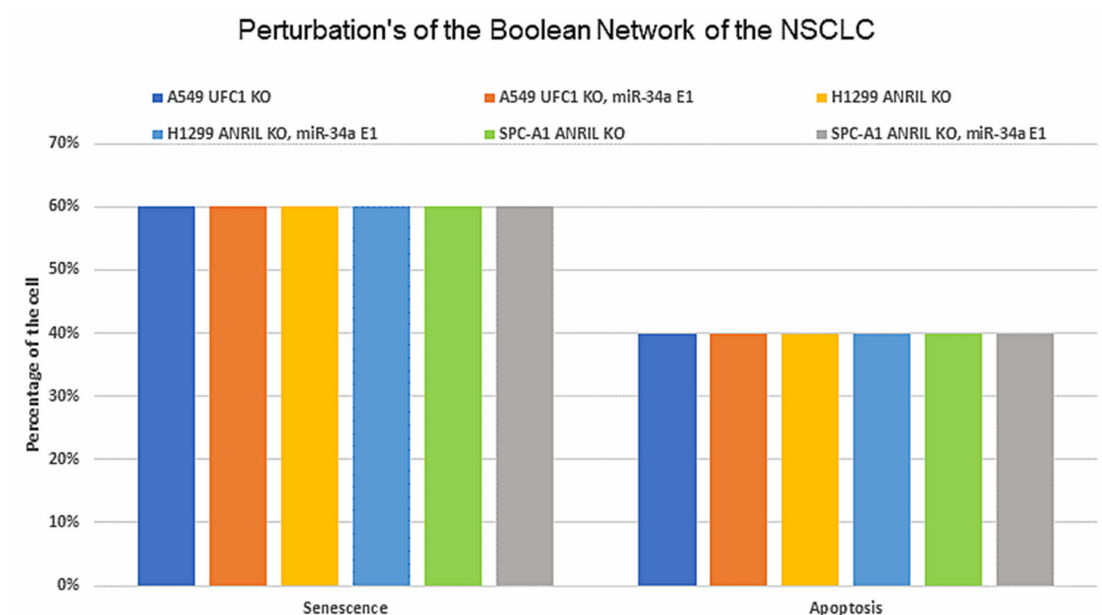
Figure 3. Probabilities of perturbed cases of Boolean networks using Monte Carlo simulations (100,000 runs) and comparison with experimental studies by Zang et al. [3] and Nie et al. [2]. Each bar represents a specific case of the perturbation. As such, the first case is UFC1 KO in A549 cells, the second case is UFC1 KO along with miR-34a E1 in A549 cells. The third case is ANRIL KO, while the fourth case is ANRIL KO together miR-34a E1 in H1299 cells. The fifth case is ANRIL KO in SPC-A1 cells, whereas the sixth is ANRIL KO along with miR-34a E1 in SPC-A1 cells. E1 represents gain-of-function (GoF) and knockdown (KO) represents loss-of-function (LoF), respectively. See Section 3.3 for more